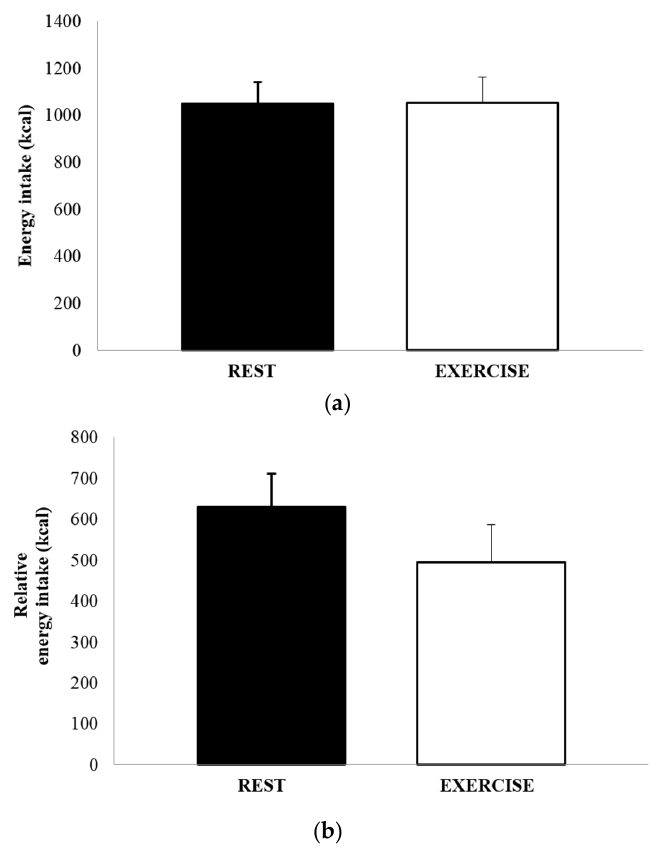
Figure 4. Absolute energy intake ( a ) and relative energy intake ( b ), for REST (solid black bar) and EX (empty bar). Values are mean ± SEM. Table 3. Food intake at the ad libitum test meal.